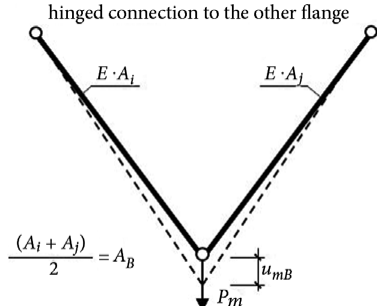
Fig. 4. Computation of coefficient of rotational elasticity of support due to flexural rigidity of cross